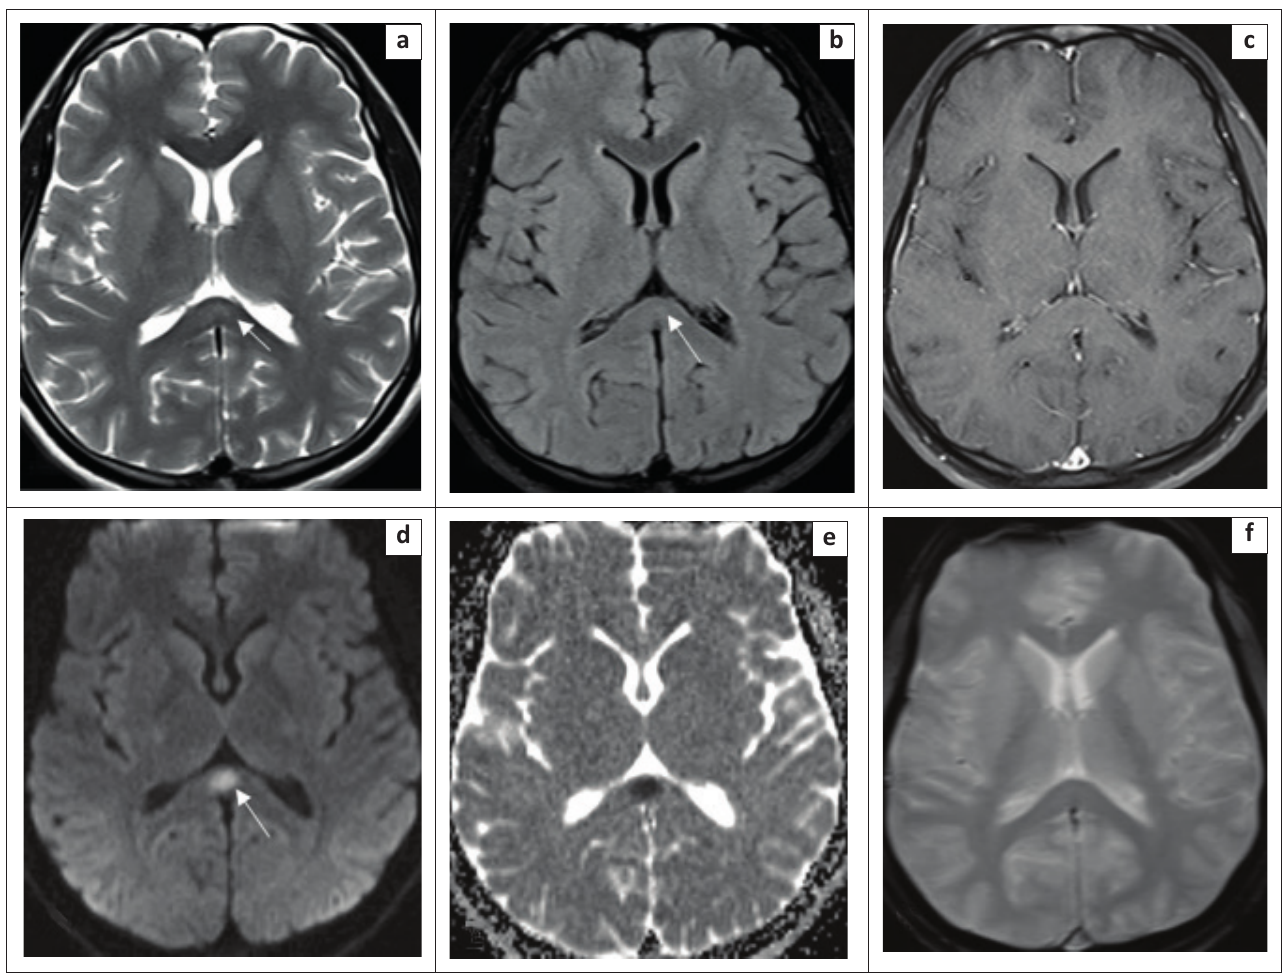
FIGURE 5: [Case 3]: Brain MRI of a 25-year-old male diagnosed with dengue fever showing a non-enhancing oval shaped T2 (a) and FLAIR (b) hyperintense lesion (white arrow) in the splenium of the corpus callosum. The lesion demonstrated no enhancement (c) and bright signal at DWI (d) and corresponding low values on apparent diffusion coefficient (e) with no blooming on the GRE images